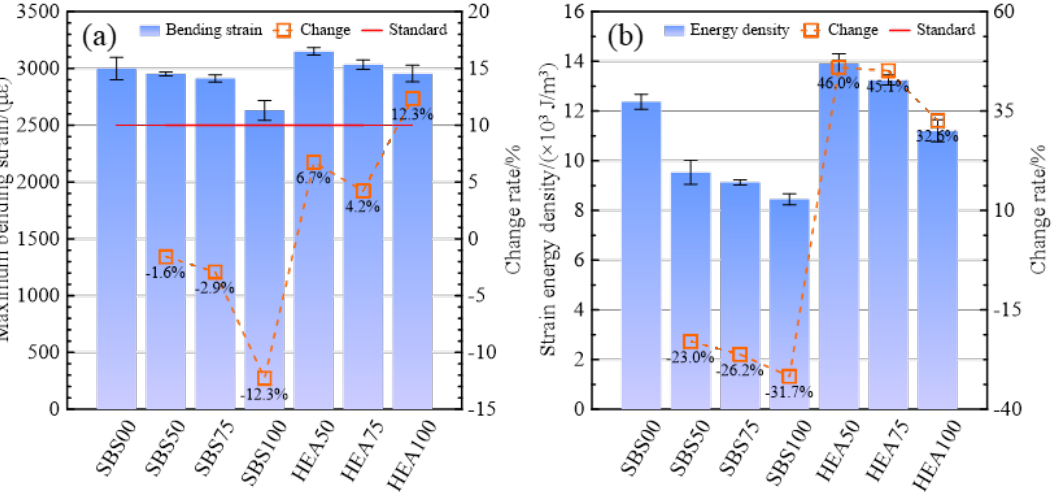
Figure 5. Low-temperature performance index of SSAM. ( a ) Maximum tensile strain; ( b ) strain energy